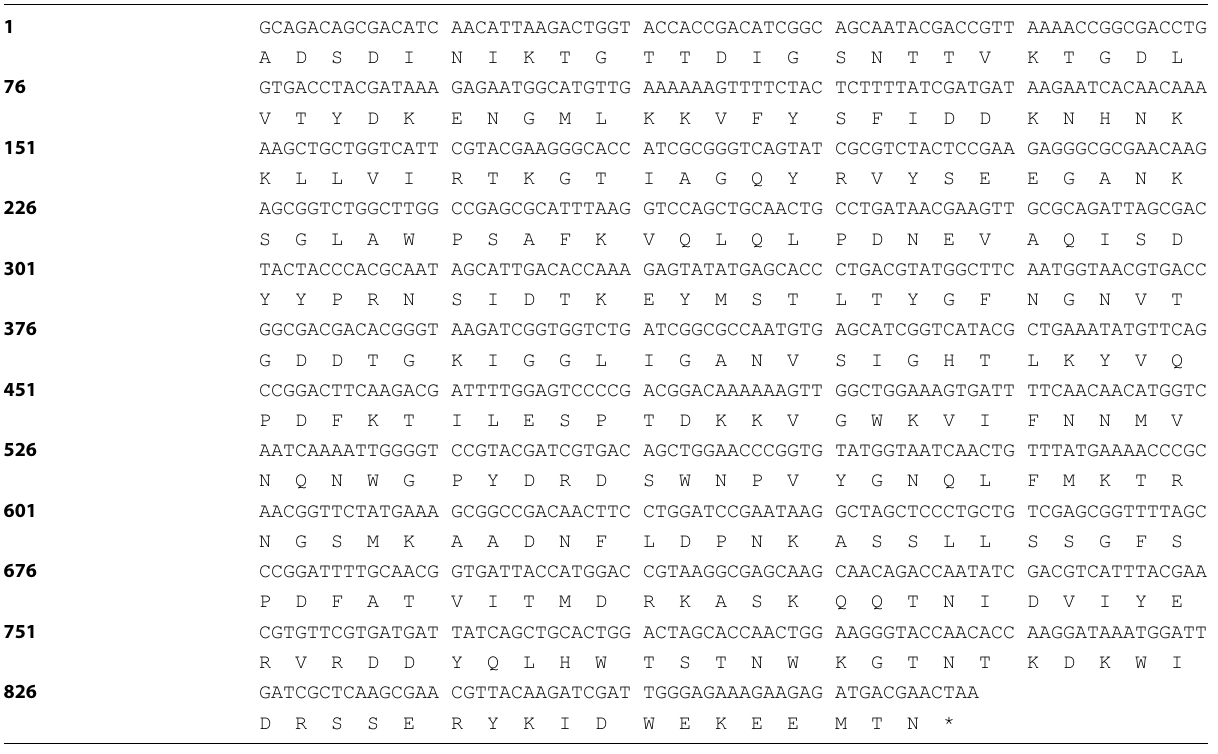
Table 1 Nucleic acid and amino acid sequences of AT